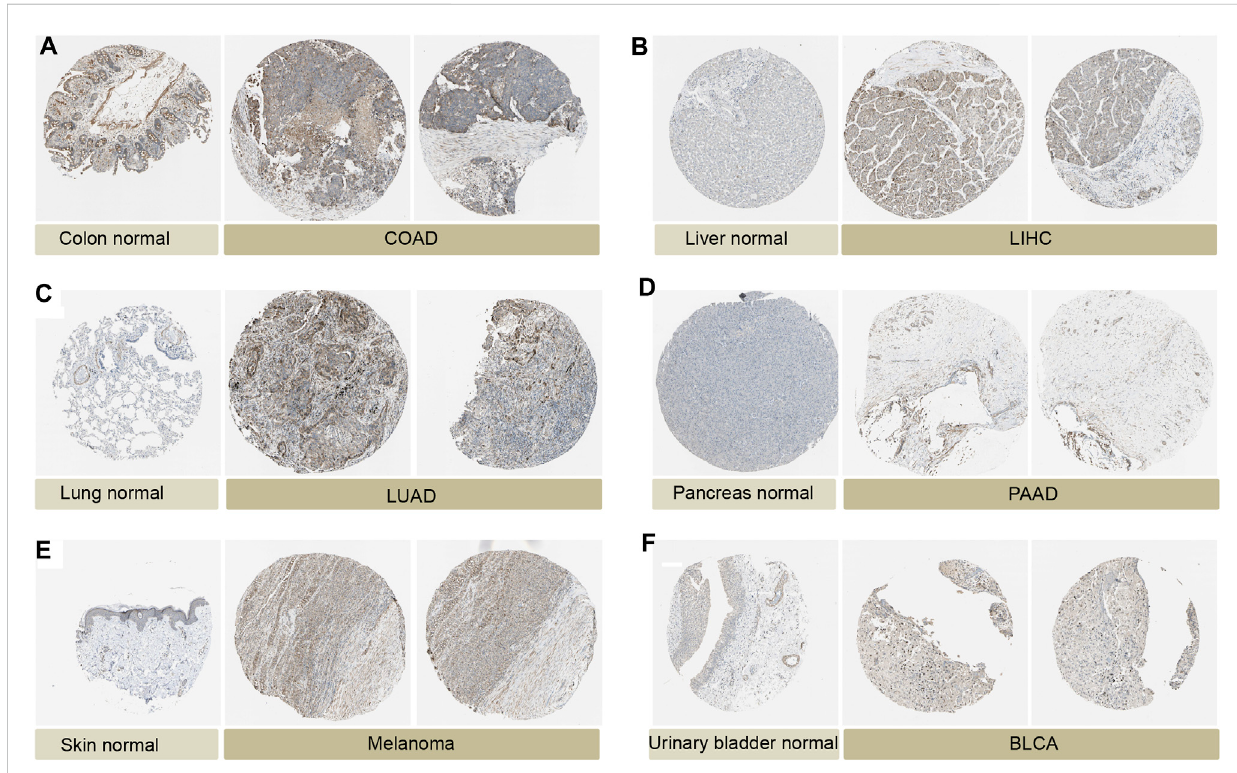
FIGURE 2 Protein expression of P4HA3 in normal and tumor tissues. Immunohistochemical staining in normal tissues and tumour tissues from the HPA database. (A) Colon normal, COAD. (B) Liver normal, LIHC. (C) Lung normal, LUAD. (D) Pancreas normal, GBM. (E) Skin normal, Melanoma. (F) Urinary bladder normal,